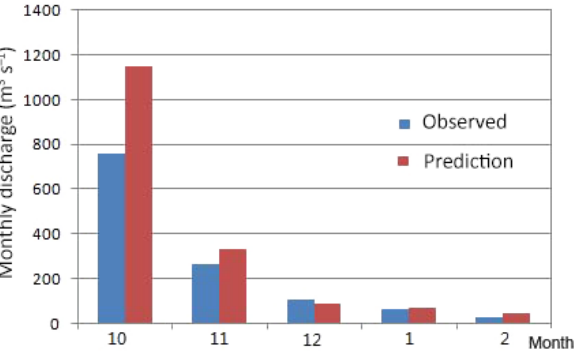
Figure 1. Predicted and observed discharge from October 2003 to February 2004 at the Jiangqiao station in the Nenjiang river.